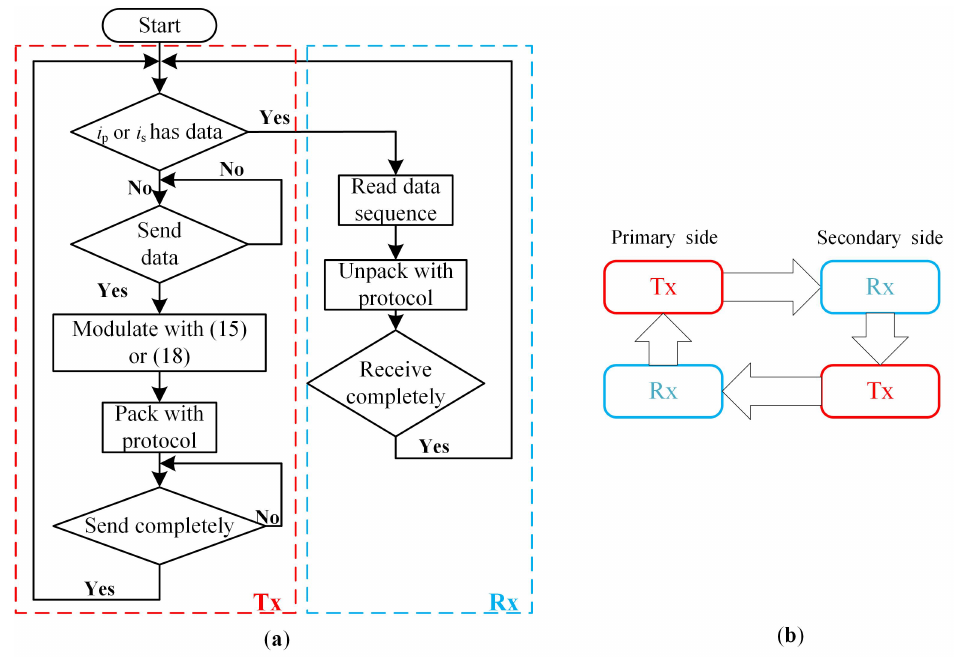
Figure 12. Diagram of the half-duplex communication. ( a ) Flowchart of “Tx” and “Rx” on primary and secondary side. ( b ) Operation sequence of SWPIT system.